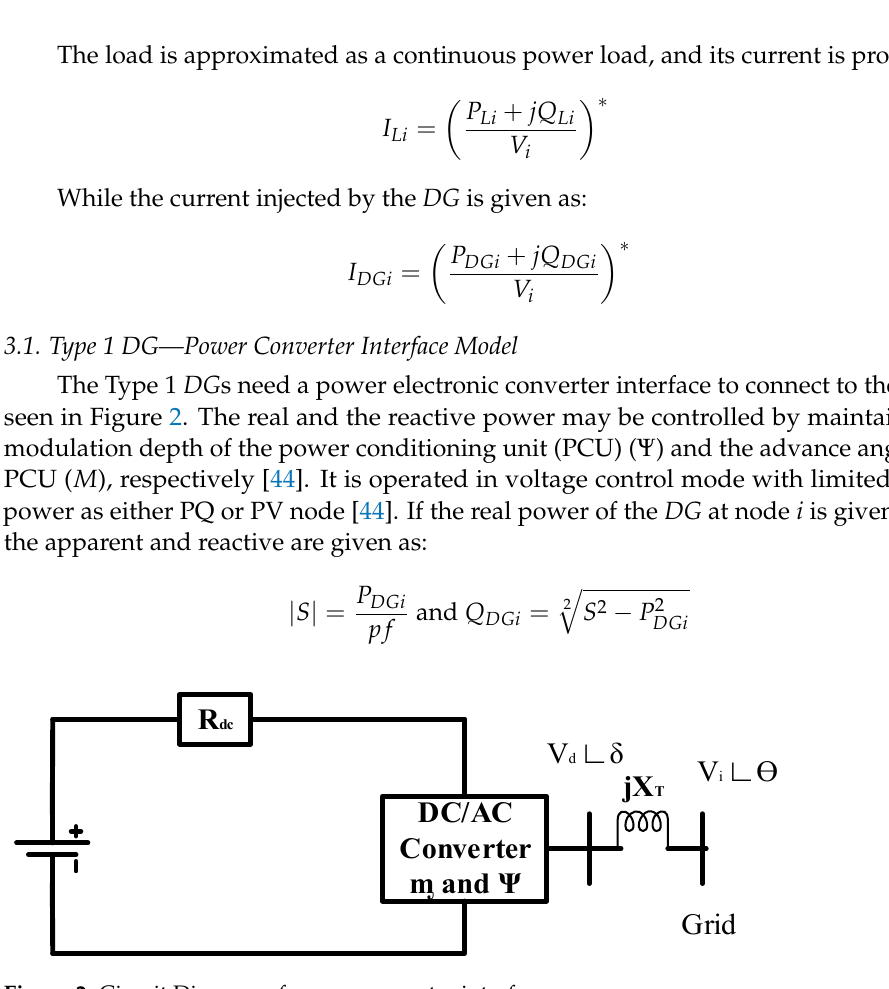
Figure 1. A DG and a PQ load connected to a bus i .